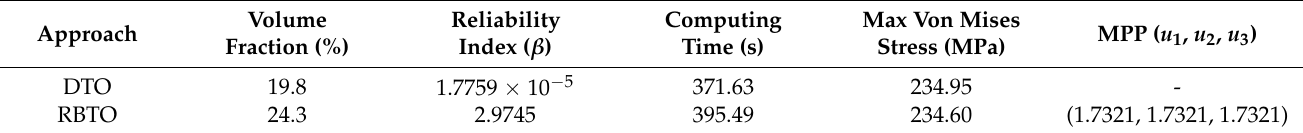
Figure 8. Reliability topology optimization result of L-beam structure (14,400 elements): ( a ) Topologi- cal structure; ( b ) Von Mises stress distribution. Table 1. Comparison of topology optimization design